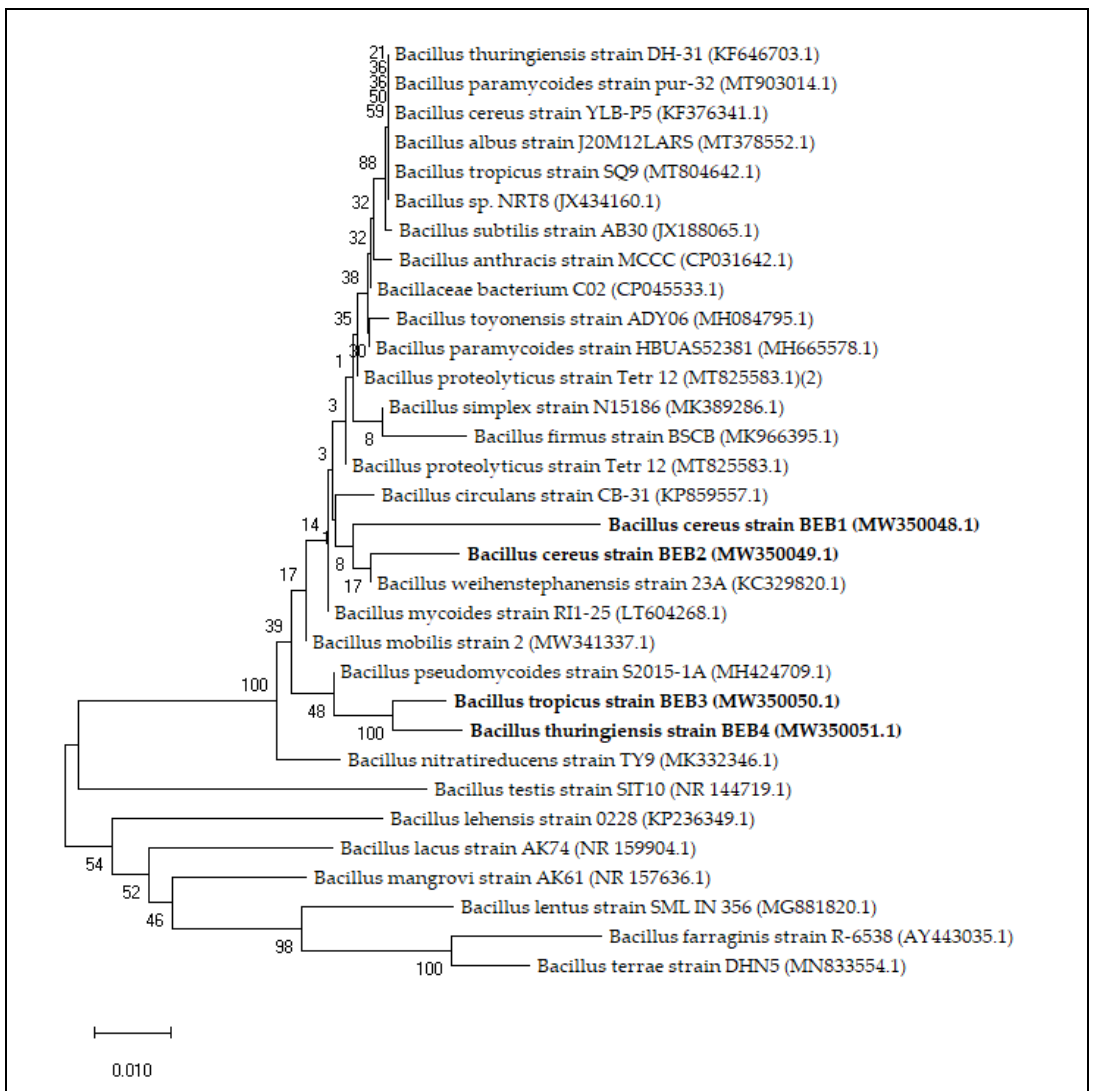
Figure 1. Phylogenetic tree based on a 16S rRNA nucleotide sequences showing the position of isolated strains among the most relevant species by BLAST comparative analysis. The tree was constructed using the Neighbor-Joining method and bootstrap values (expressed as percentage of 100 replications) are shown at branching points.